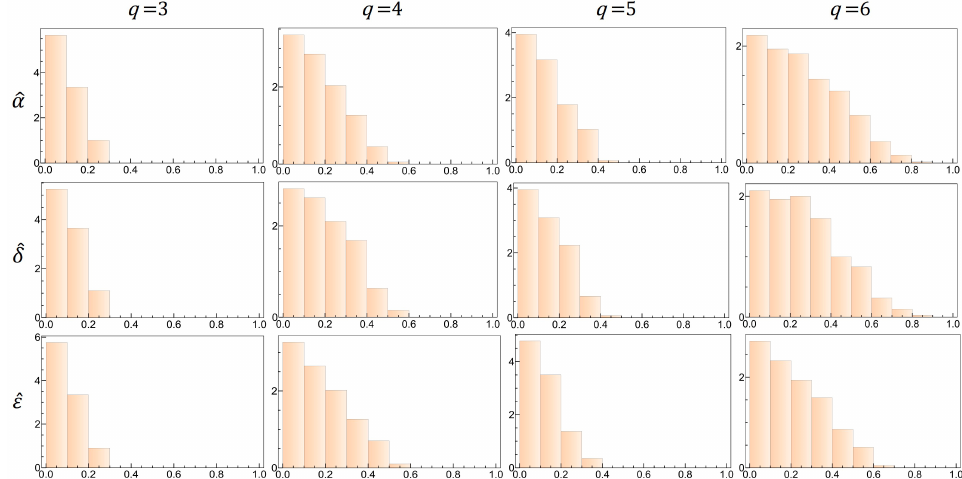
Figure 14: Distance distributions as in Fig. 13, for different architectures of INCA. memory. On this infrastructure, training the networks takes about 4 days for both ENCA and INCA for model (9), and 3 (ENCA) and 7 (INCA) days for model (13). The ABC inference takes CPU cores by tensorflow (version 2.2) and SPUX,